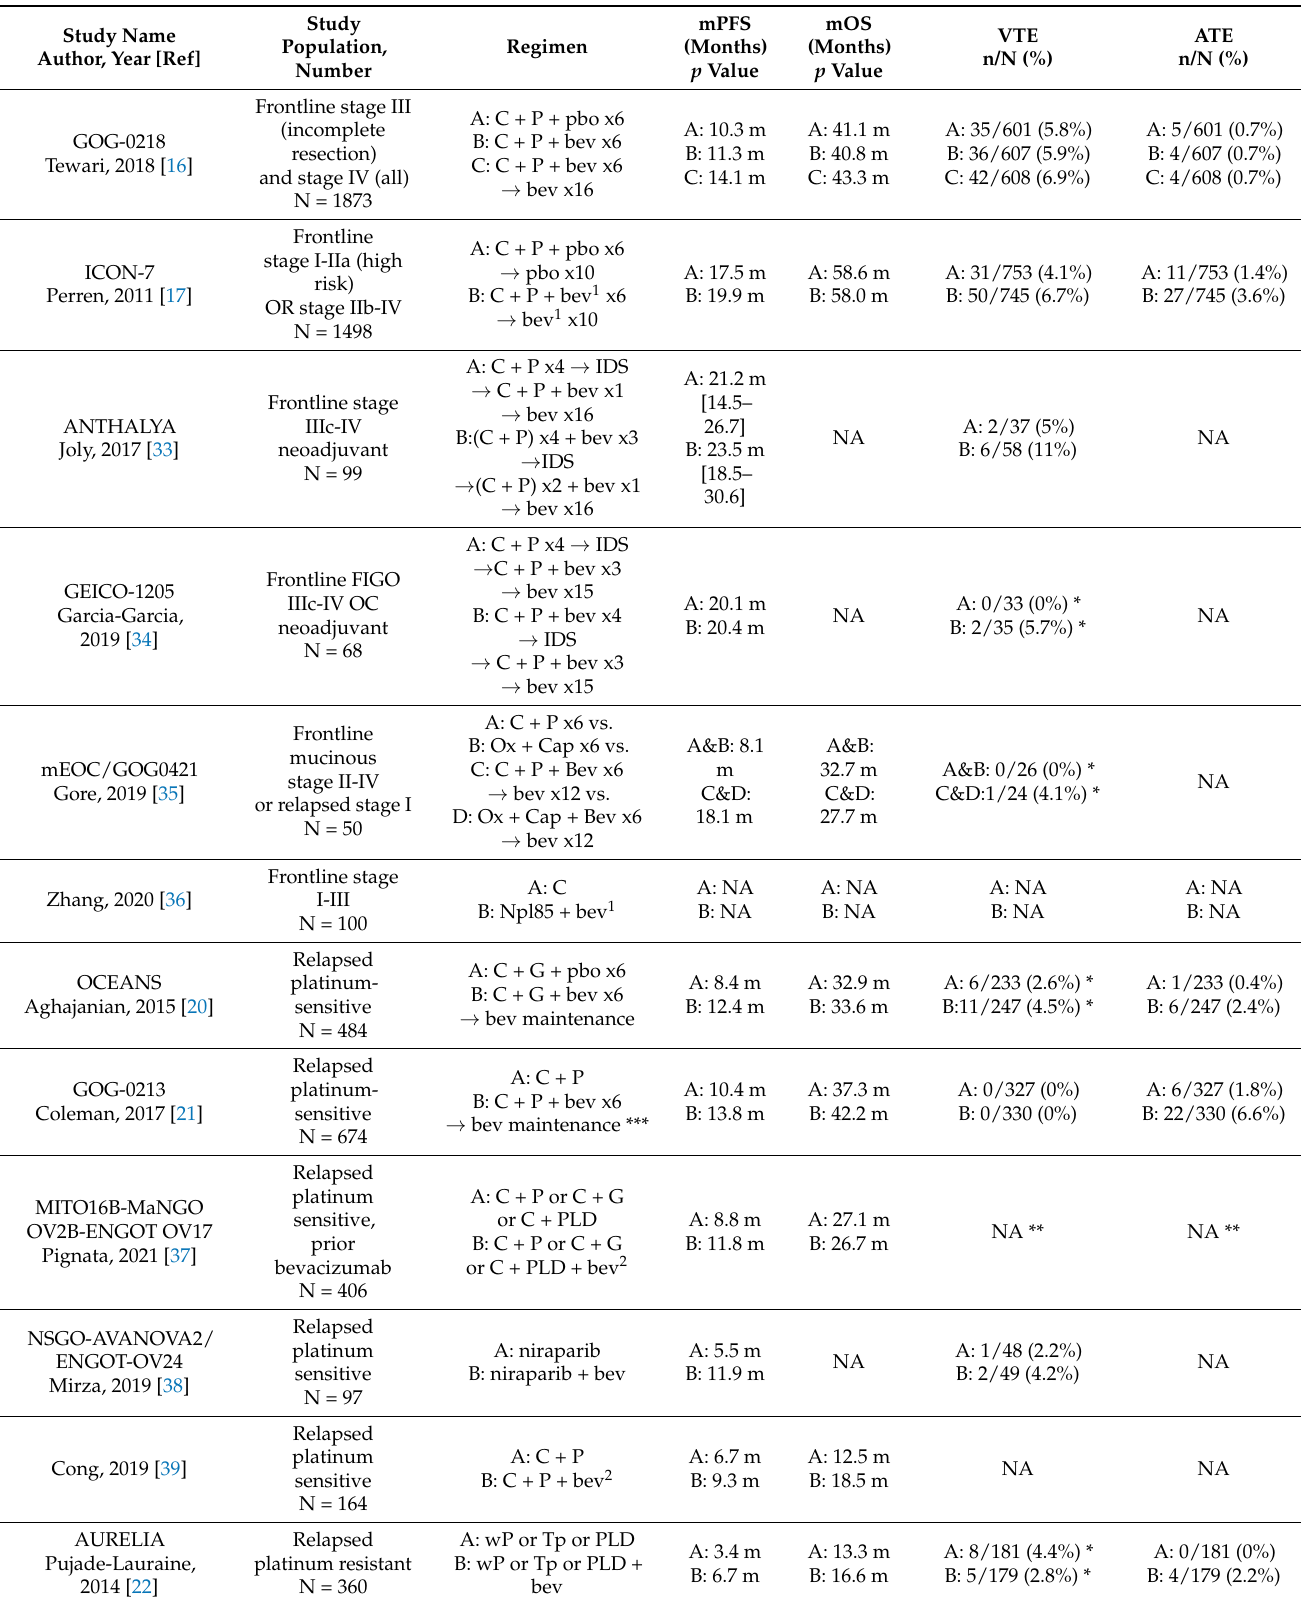
Table 1. Overview of the studies with and without bevacizumab in ovarian